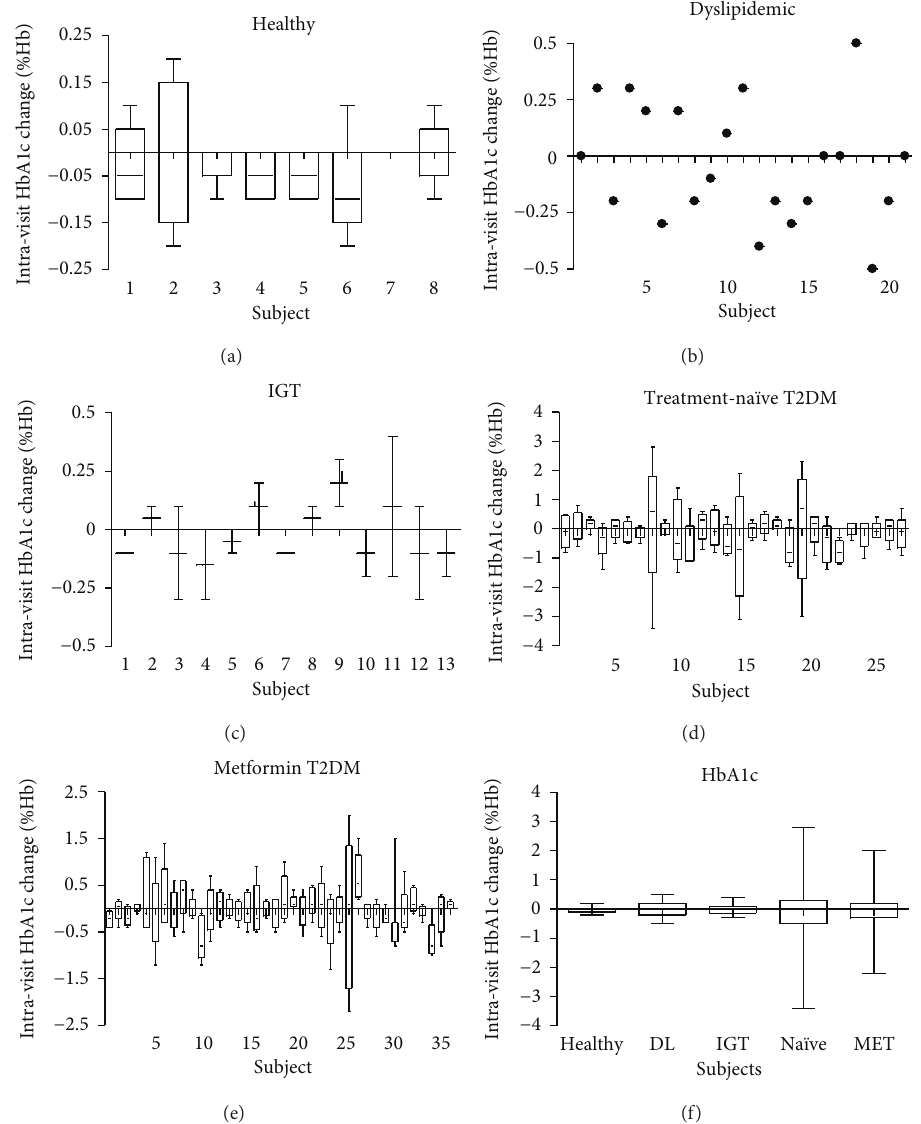
F 3: Intrasubject HbA1c changes in placebo comparisons. Bar and whisker plots of the change in HbA1c between visits for individual subjects: (a) healthy subjects from study 2100-202, (b) dyslipidemic subjects from study 2200-130, (c) impaired glucose tolerance subjects from study 3286-0102, (d) treatment-naïve type 2 diabetes patients from HE3286-0401 cohort 2, (e) type 2 diabetic patients on a stable dose of metformin from HE3286-0401 cohort 1, (f) intravisit changes for all subjects from each condition plotted on the same scale. IGT: impaired glucose tolerant, Metformin T2DM: uncontrolled type 2 diabetes mellitus participants on a stable dose of